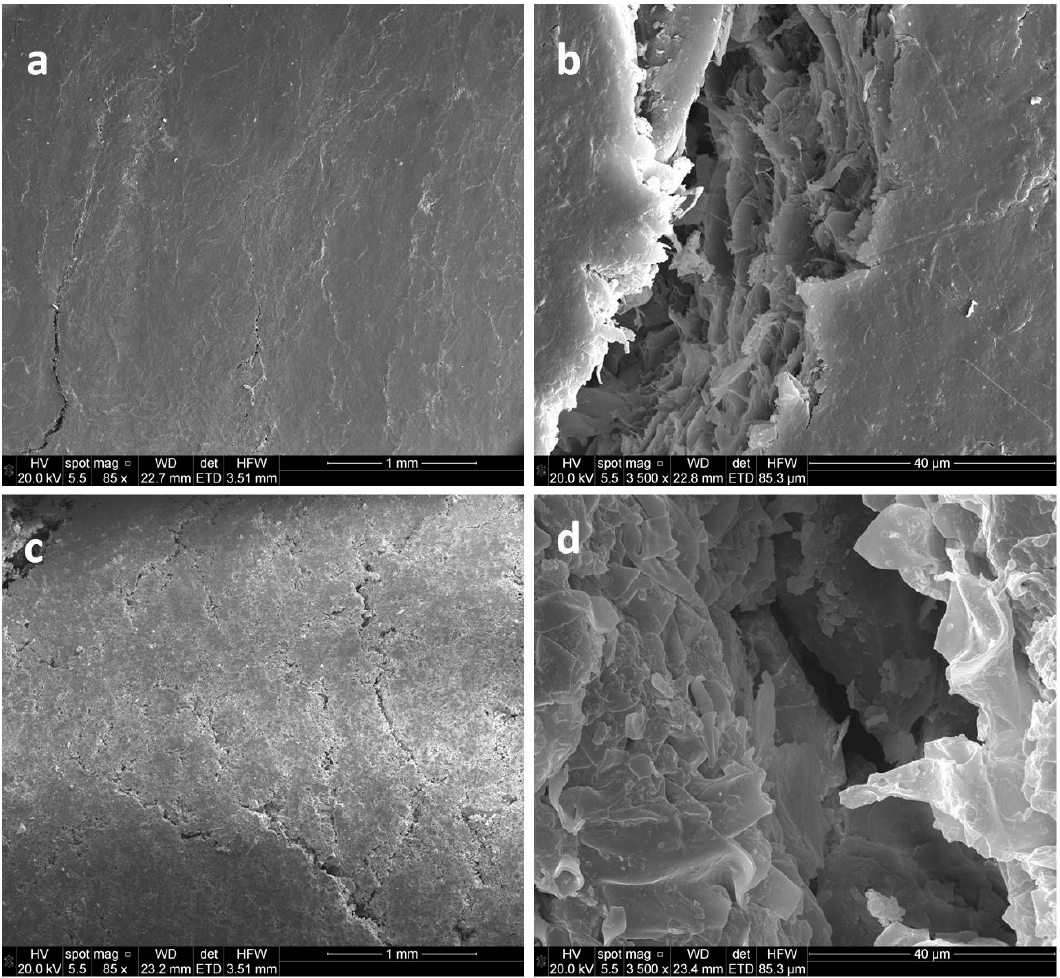
Figure 7. SEM images for longitudinal section of eucalyptus ( a , b ) and cork ( c , d ) wastes ( b , d , focusing on a fissure).